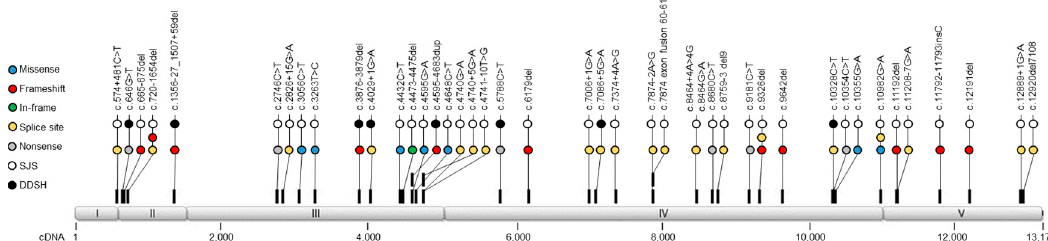
Figure 3. Location of HSPG2 mutations identified in Schwartz-Jampel syndrome (SJS) and dyssegmental dysplasia, Silverman-Handmaker type (DSSH) patients. Schematic representation of HSPG2 domain (I–V) encoding organization with corresponding locations of mutations. Mutation types are indicated by colored circles, with white and black indicating whether the mutation was identified in either a SJS or a DDSH patient, respectively. Mutations are identified by their cDNA sequence (Genbank M85289.1) as depicted below and follow the accepted nomenclature system [96].